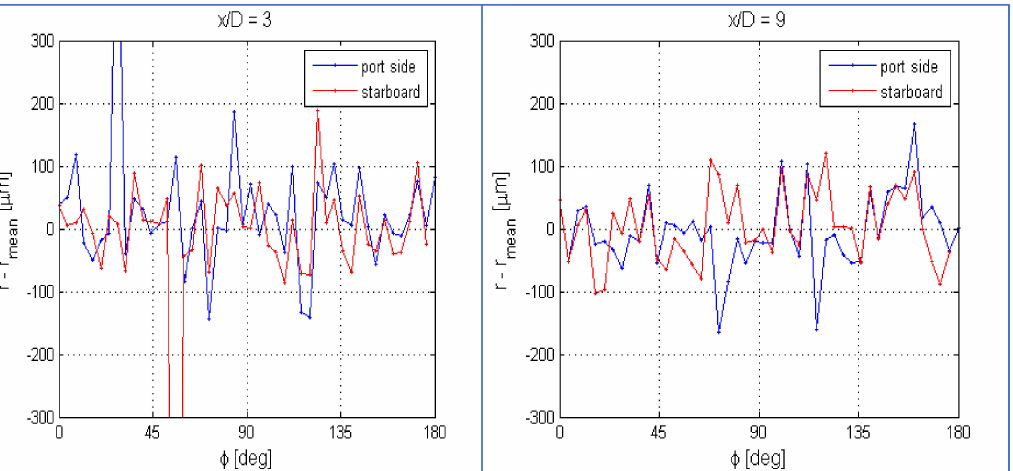
Figure 8. Grid U1. Difference between the ideal and real radius at two x/D cross sections as a function of the roll